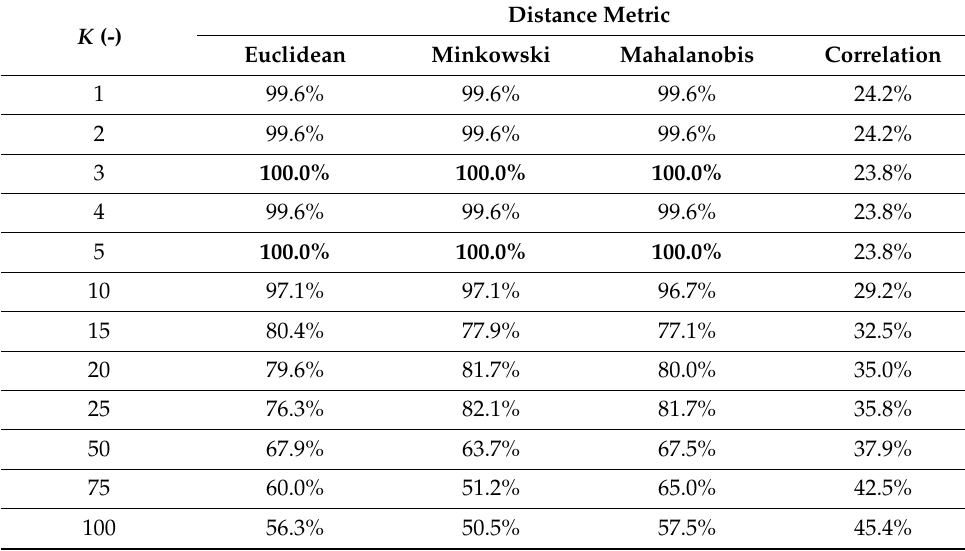
Figure 10. The impact of the K-nearest neighbors value and distance metric on the KNN classifier accuracy.